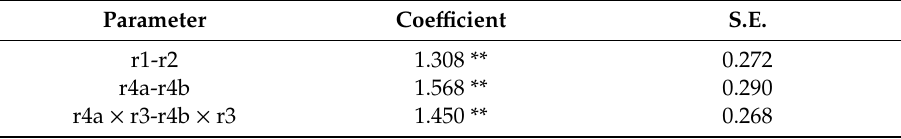
Table 6. Comparative study results of impact e ff